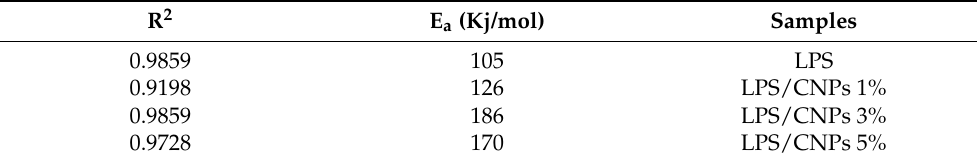
Table 5. The E a and the correlation coefficient calculated by the OFW method. 2 R E a (Kj/mol) Samples